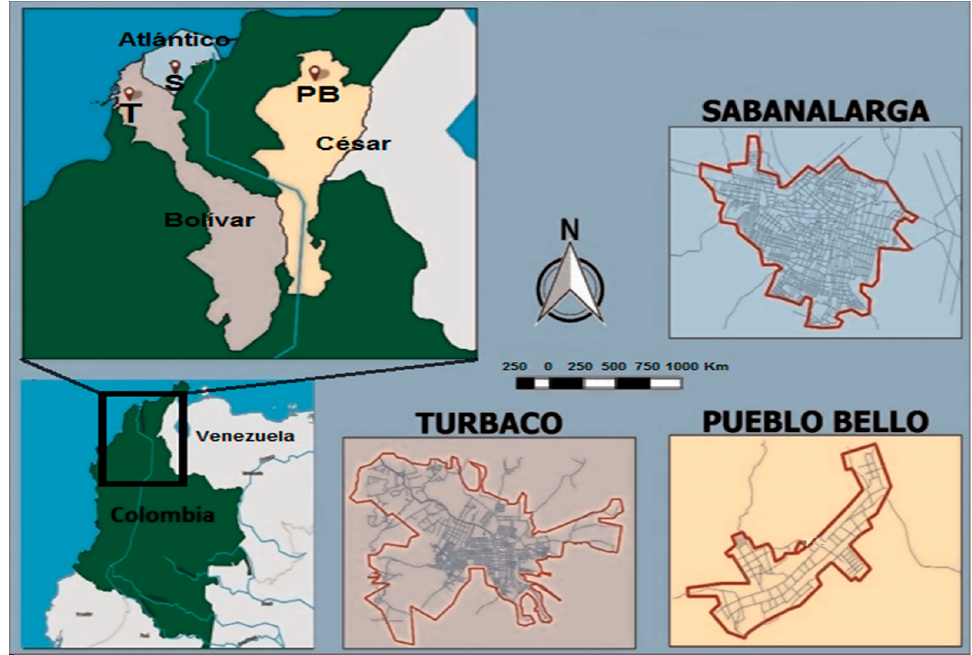
Figure 1. Map of the study sites including the municipalities of Turbaco, Sabanalarga and Pueblo Bello.